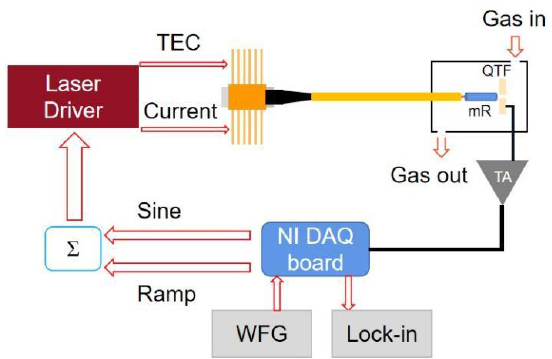
Figure 2. Schematic of sub-mL QEPAS system. WFG: Waveform Generator; NI DAQ board: National Instruments data acquisition board; TEC: Thermoelectric Cooler; mR: micro-resonator tube; QTF: quartz tuning fork; TA: transimpedance amplifier.